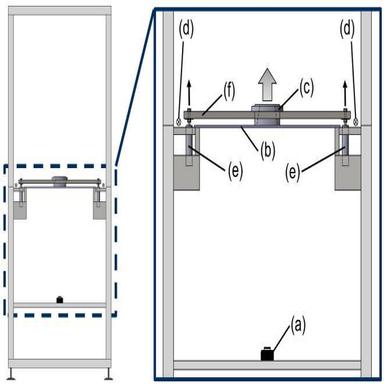
Shows the deviations of the automatic measurement technique by an idealised circle in contrast to the actual contour of the final slump flow.